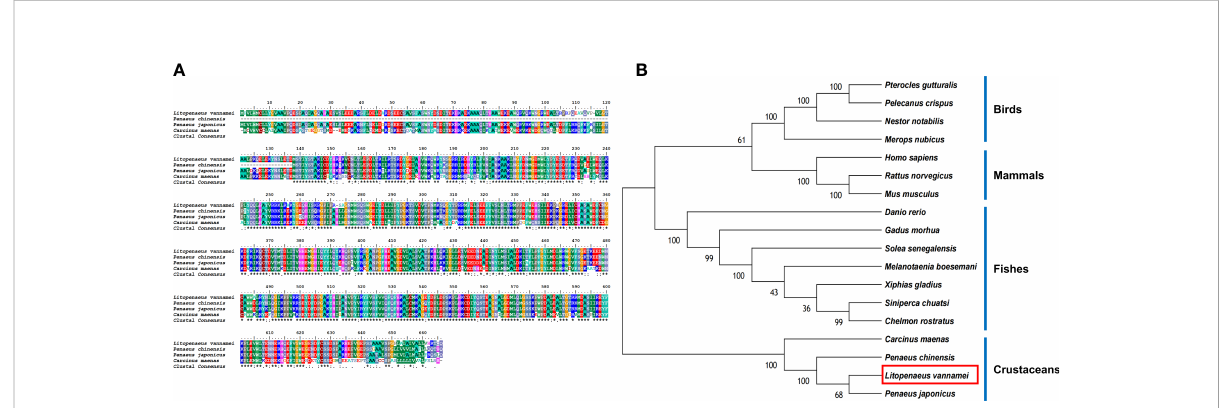
FIGURE 2 (A) Multiple alignments of deduced amino acids of LV-ACE protein and its homologs. Species names are listed on the left side. (B) The phylogenetic tree shows relationships between the ACE protein of L. vannamei (red rectangle) and those of other organisms. Species names are listed to the right of the